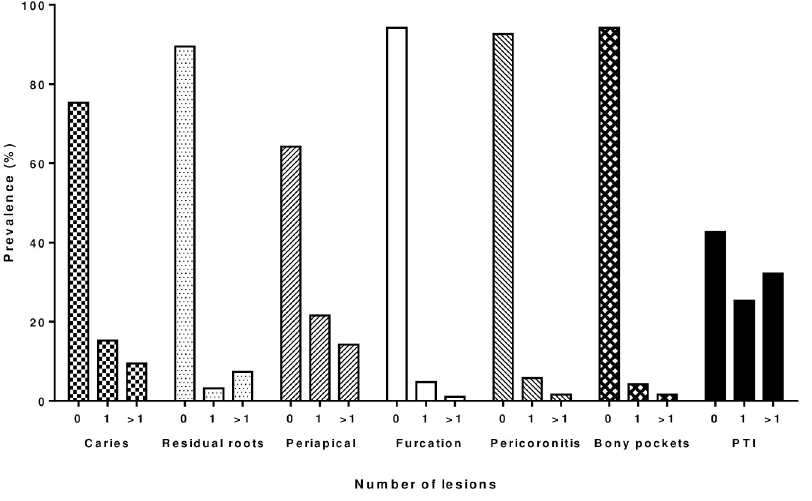
Fig 1. Prevalence of panoramic radiograph findings at baseline. PTI = Panoramic tomographic index.